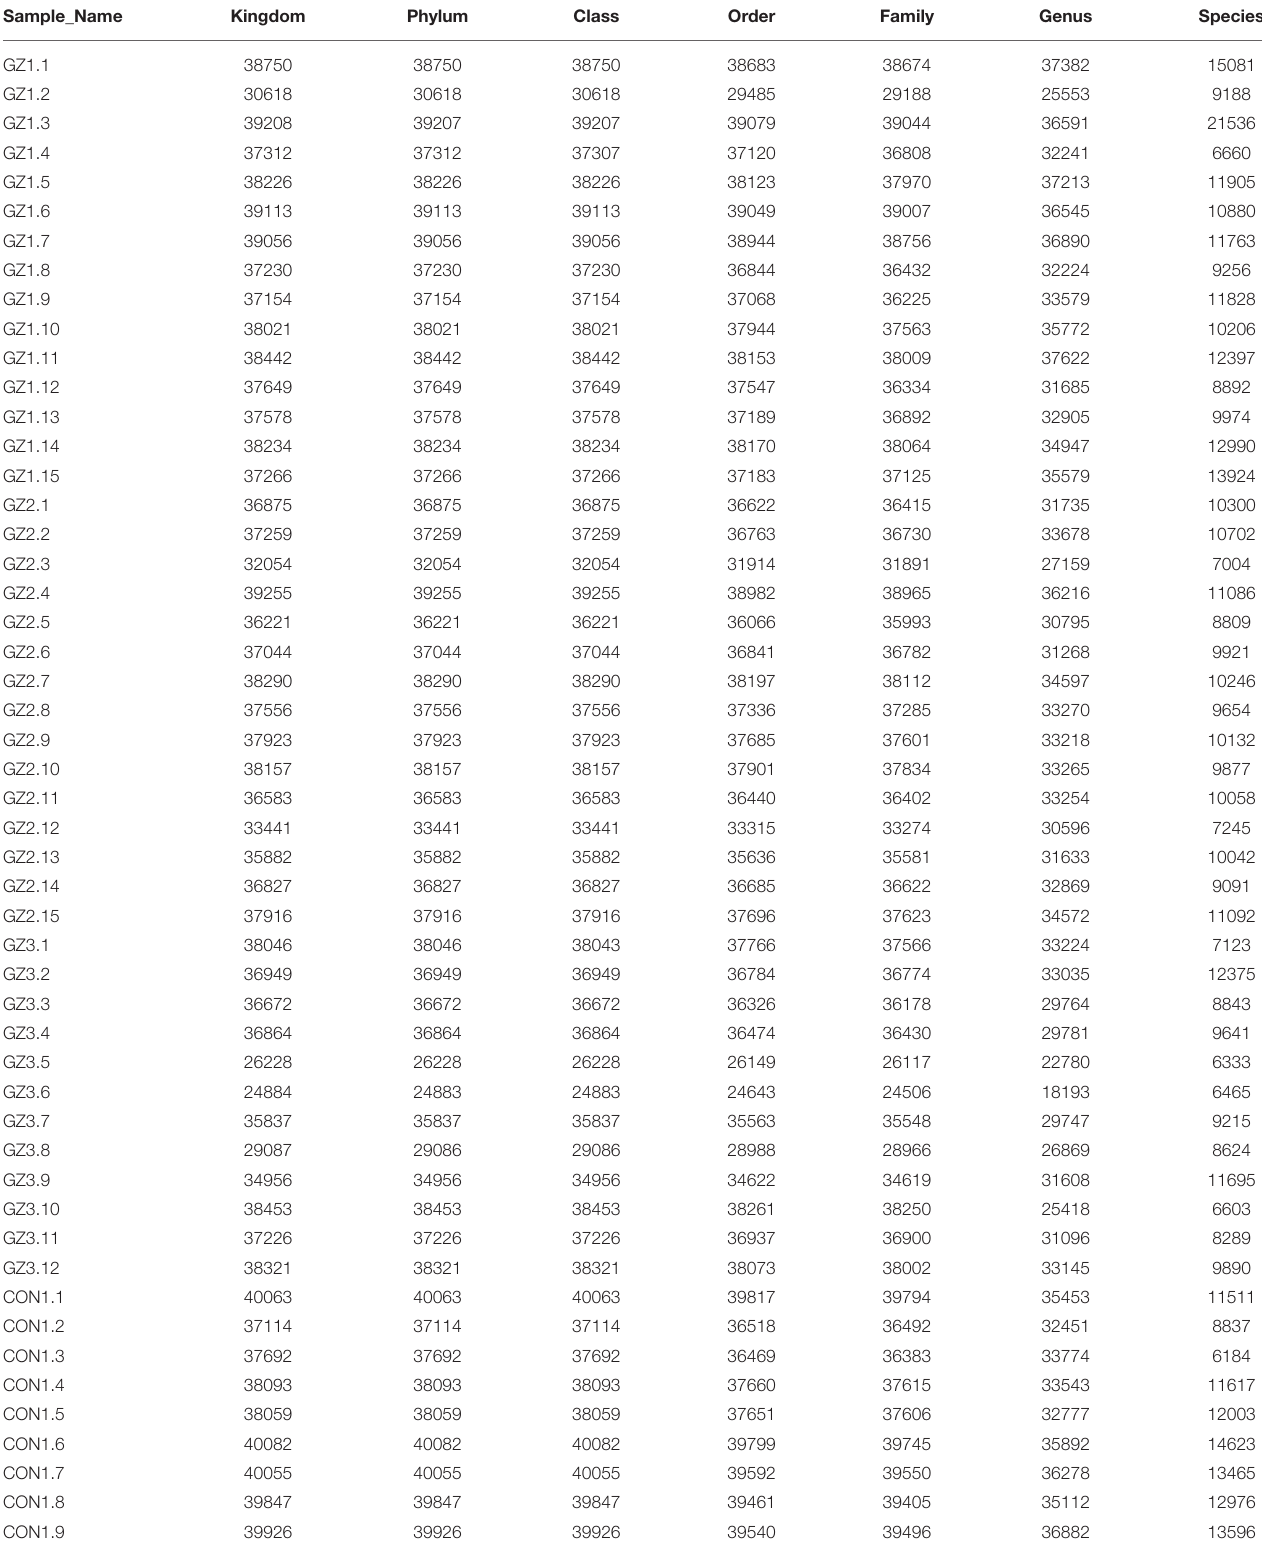
TABLE 1 | Number of gene sequences in each sample ( Figure 1 data supplement